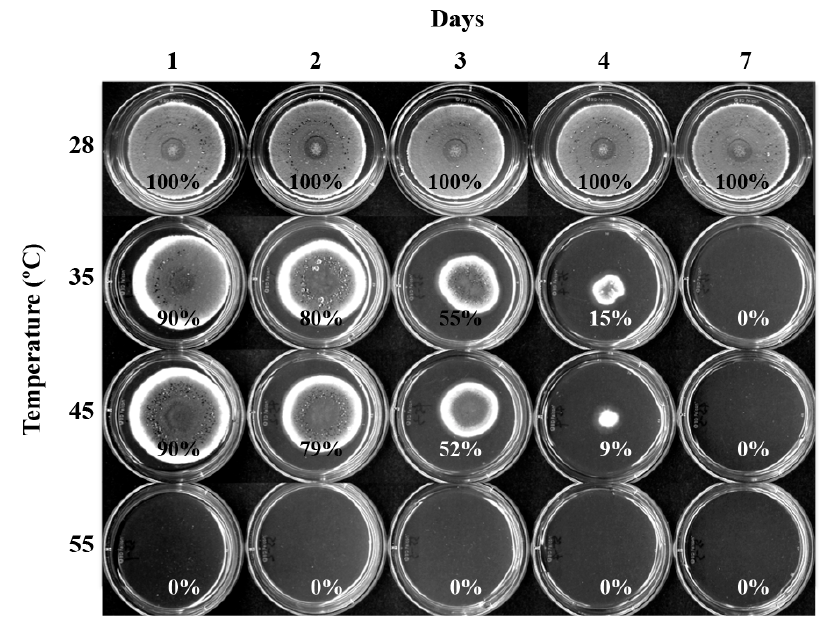
Figure 2. Fungal plate bioassay showing sensitivity of P. expansum W1 to high temperatures (35, 45, 55 °C). The % values shown are relative growth rate of W1 compared to that at 28 °C (positive control). SD <